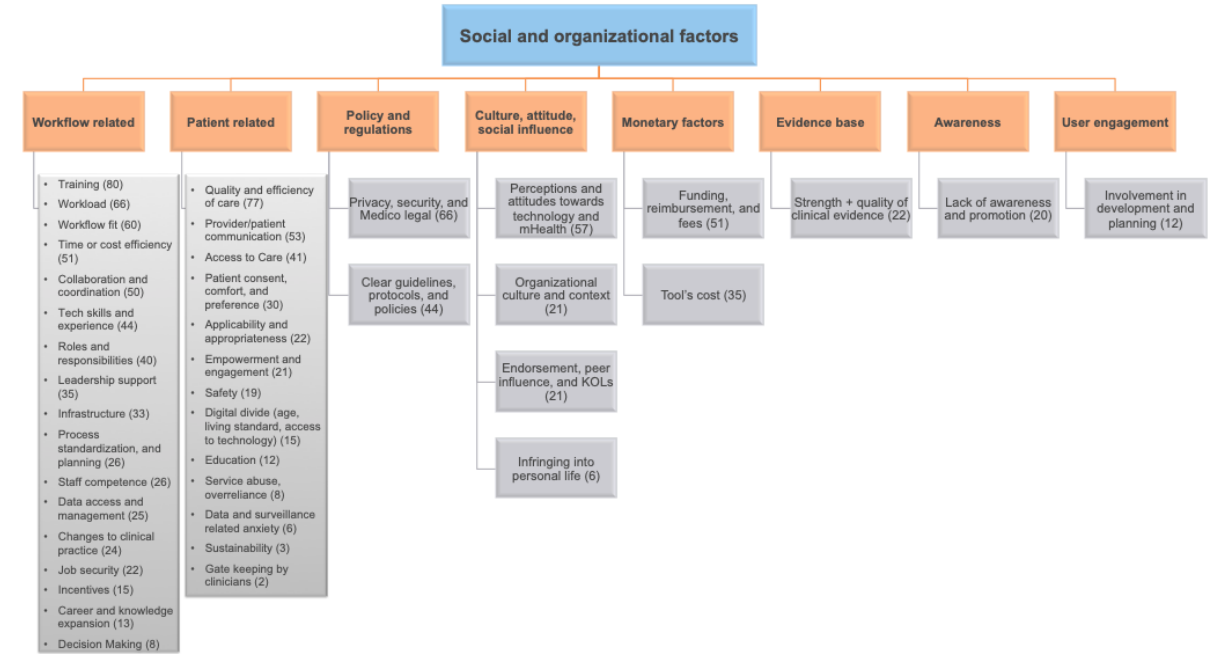
Figure 4. Overview of social and organizational factors and their occurrence. mHealth: mobile health; KOL: key opinion leader.